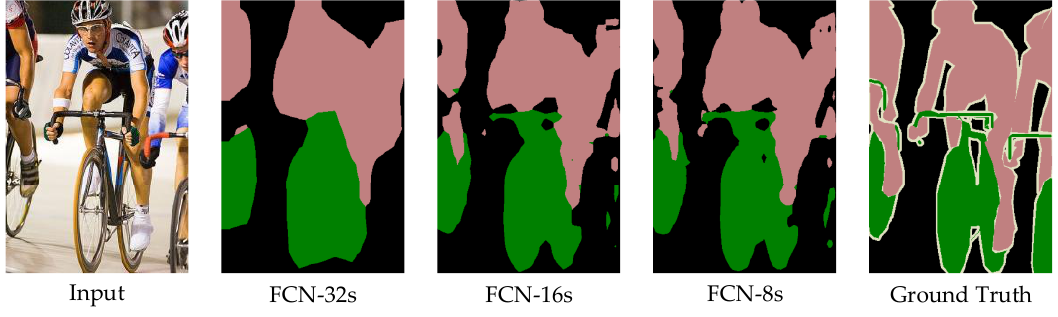
Figure 2. The features extracted from FCN models.